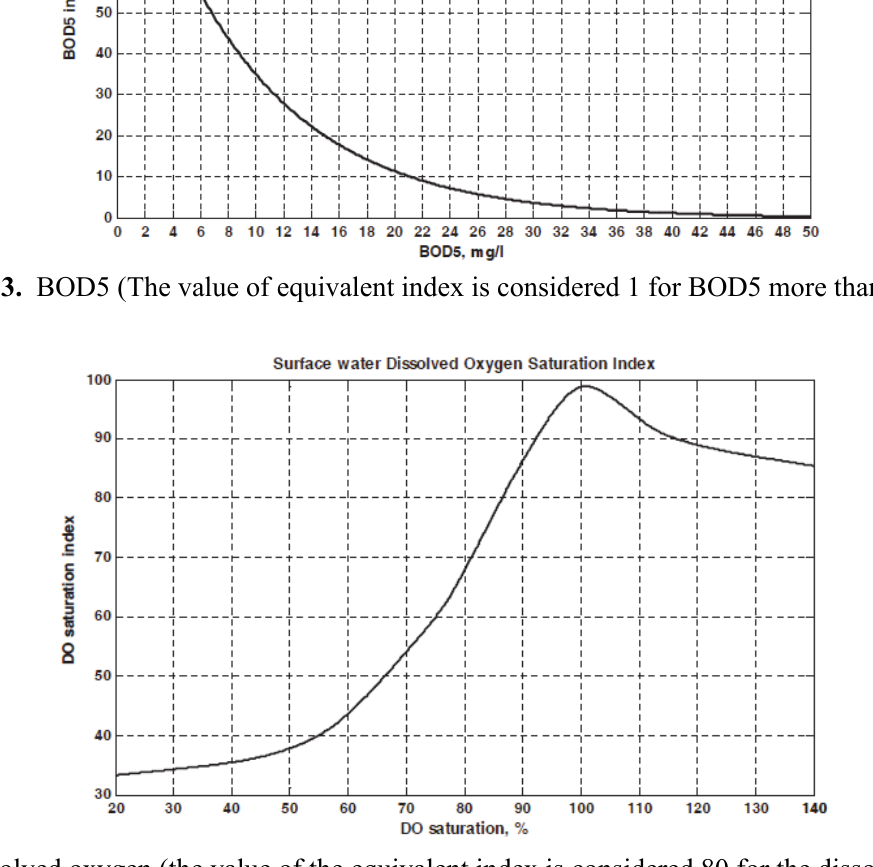
Fig. 4. Dissolved oxygen (the value of the equivalent index is considered 80 for the dissolved oxygen more than 140% of